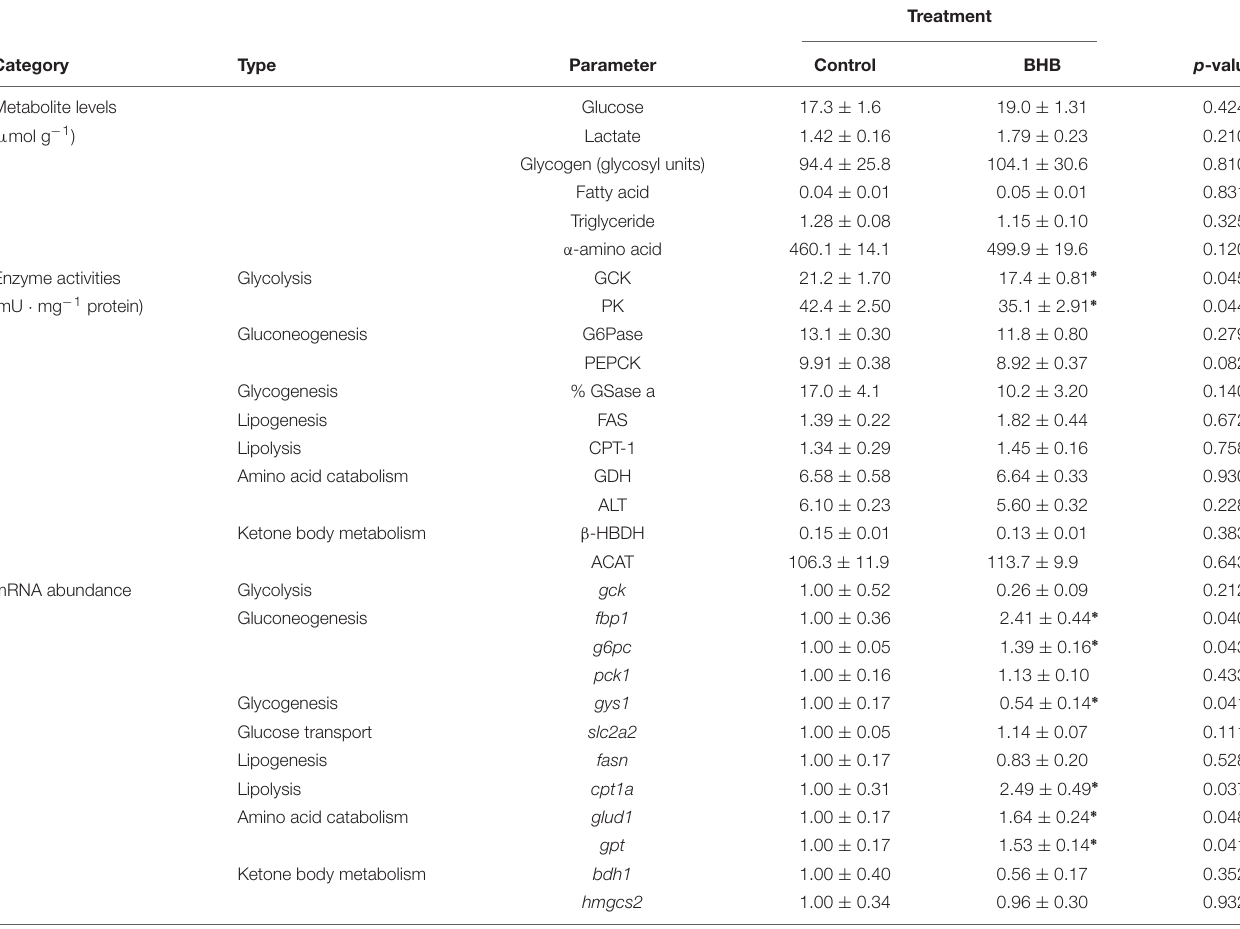
TABLE 5 | Levels of metabolites, enzyme activities, and relative mRNA abundance of transcripts in liver of rainbow trout 6 h after intracerebroventricular administration of 1 µ L 100 g − 1 body mass of saline solution alone (control) or containing 0.5 µ mol of β -hydroxybutyrate